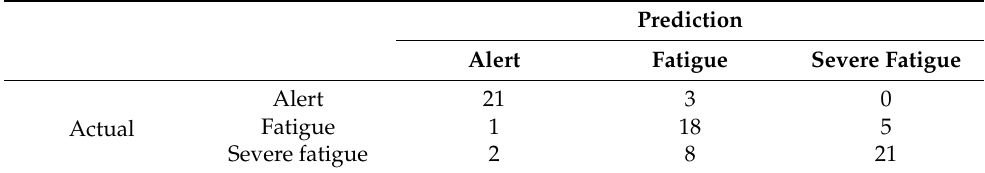
Table 5. Confusion matrix based on the k -nearest neighbor algorithm (the test results when the test accuracy reaches the maximum).